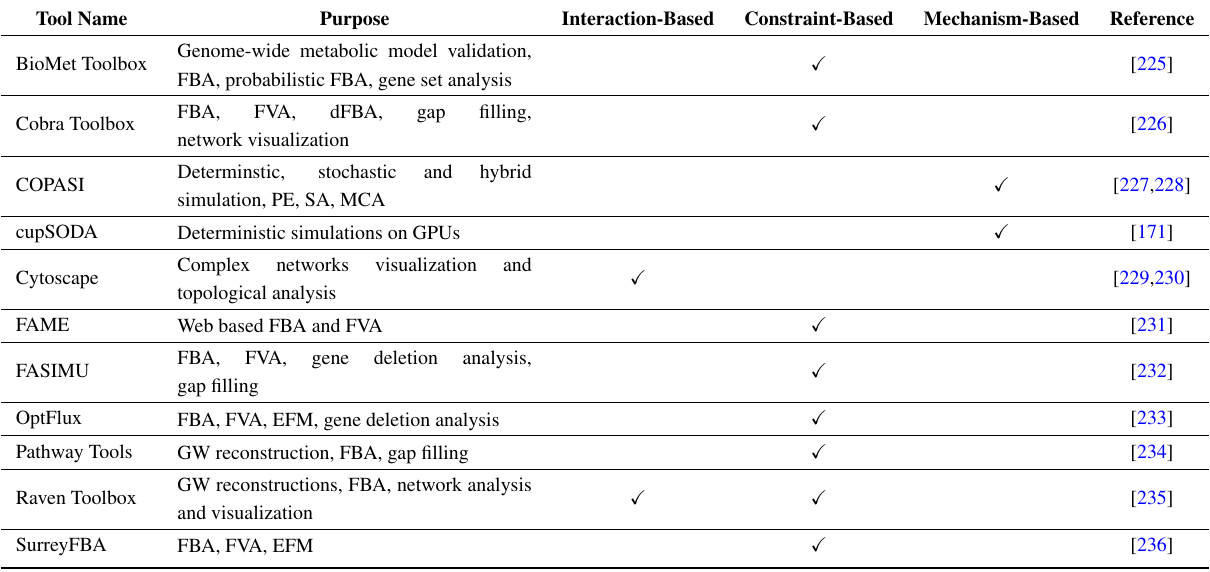
Table 2. Main computational tools used in the modeling, simulation and analysis of metabolism.